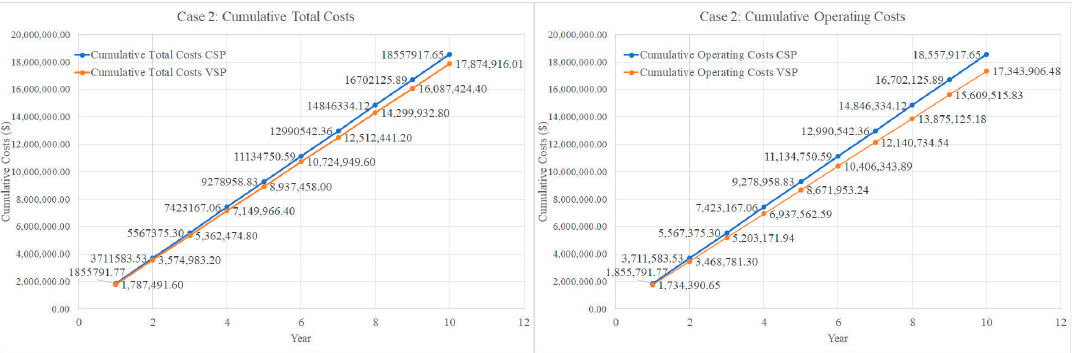
Figure 9. Case 2: Cumulative total (left) and operating (right) costs with both CSPs and VSPs.